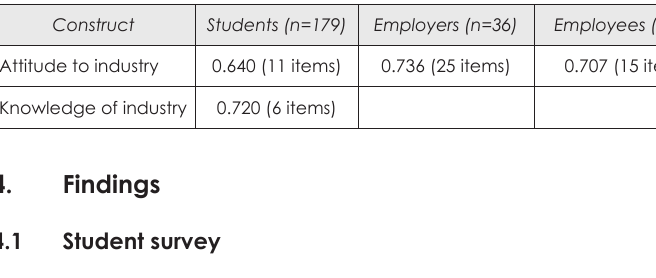
Table 2: Profile of student sample